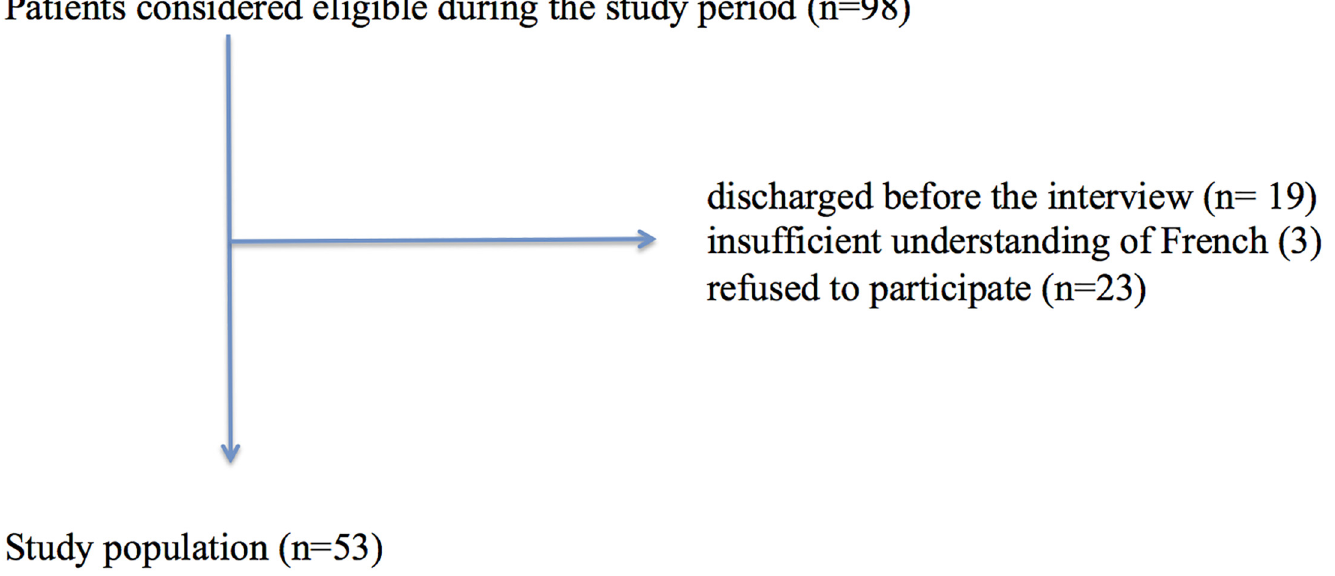
Fig 1. Algorithm dedicated to medication history in an obstetrical